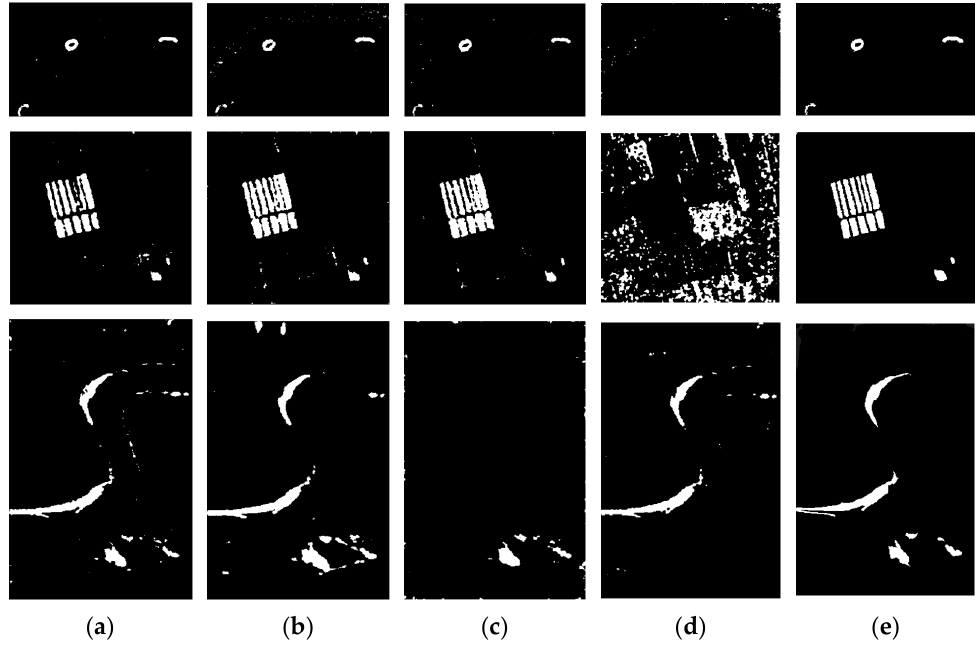
Figure 14. CD results of swapping the input sequence of bi-temporal images for FC-Siam-diff and FC-Siam-conc. ( a , b ) correspond to the results of FC-Siam-diff switching the input sequence. Similarly, ( c , d ) correspond to the results of FC-Siam-conc. ( e ) Ground truth. These three datasets are Yellow River coastline (first row), Farmland-A (second row), and inland water (third row).